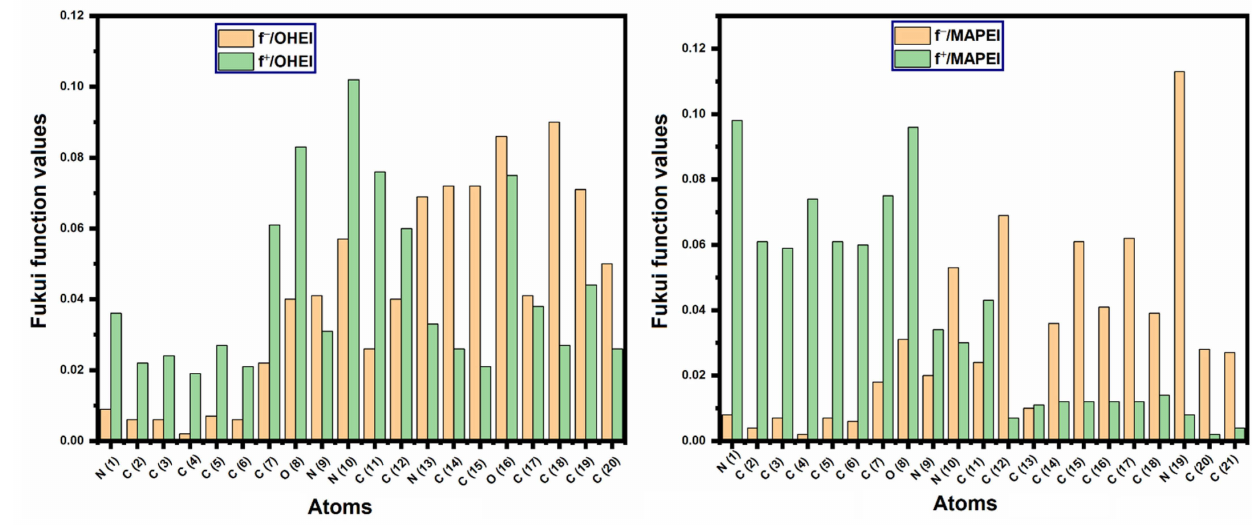
Figure 7. Graphical illustration of Fukui function indices of OHEI and